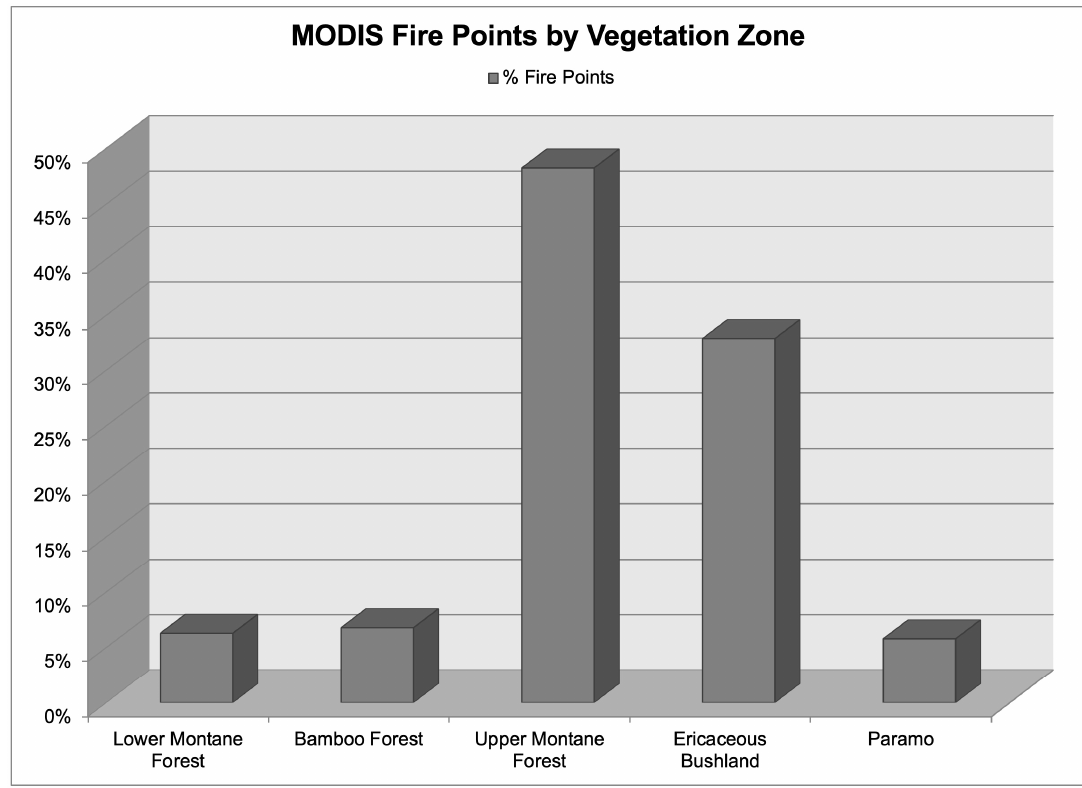
Figure 4. Distribution of MODIS active fire detection points by vegetation zone.